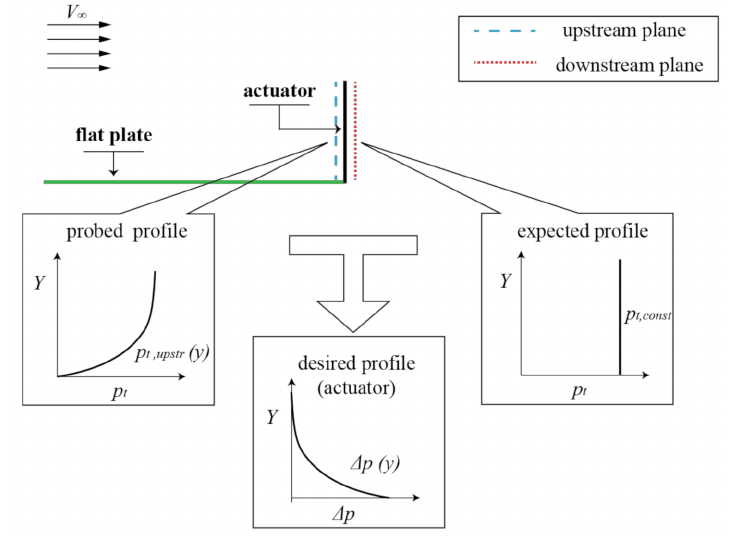
Figure 10. The scheme of a wake filling actuator model